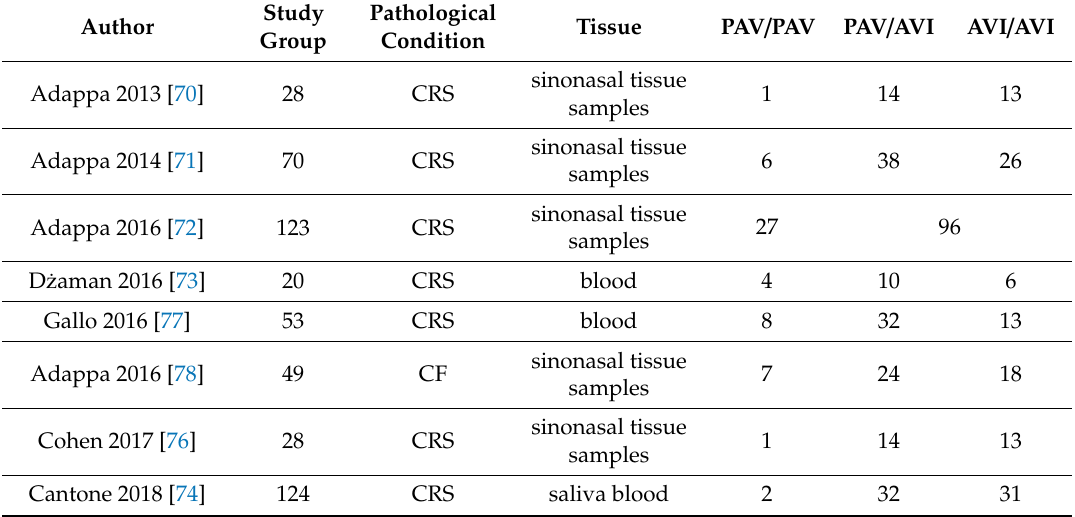
Table 2. TAS2R38 polymorphisms in selected studies in patients with chronic rhinosinusitis (CRS) and cystic fibrosis